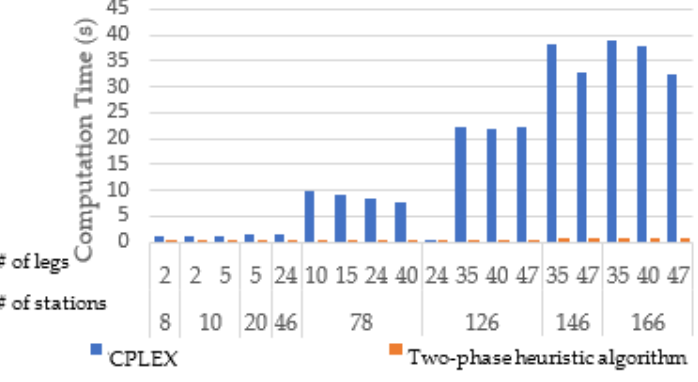
Figure 6. Computation times according to number of stations in problem